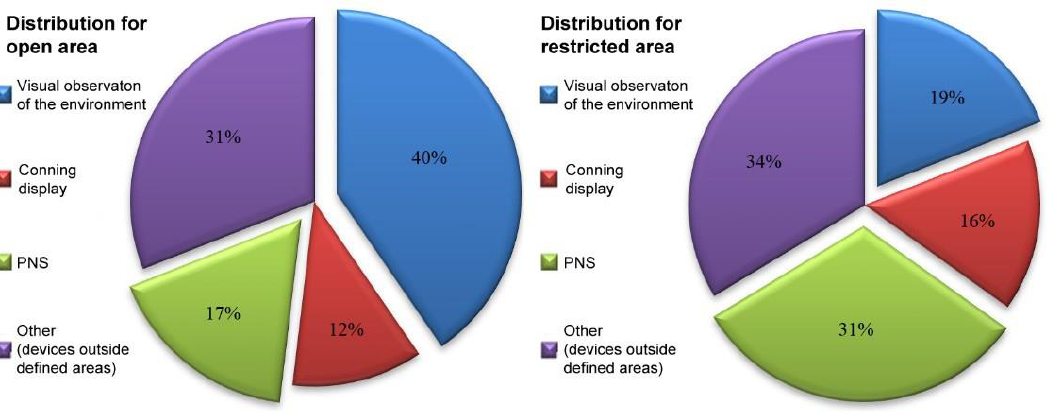
Figure 5. The location of AoIs defined for the preliminary experiment.